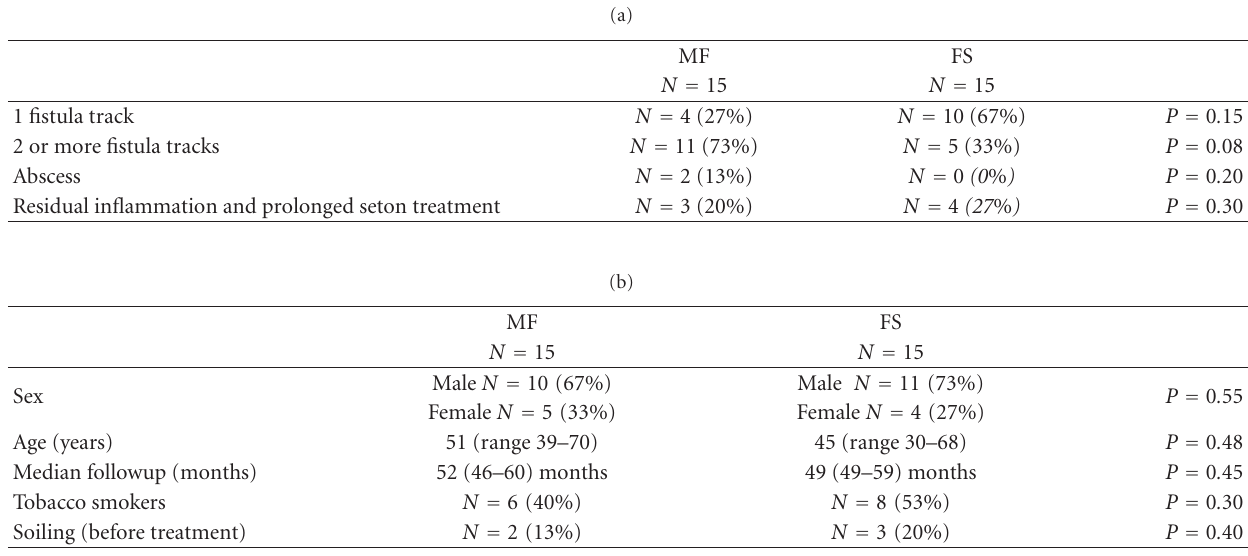
Table 1: (a) Patient characteristics of the fistula. (b) patient characteristics.